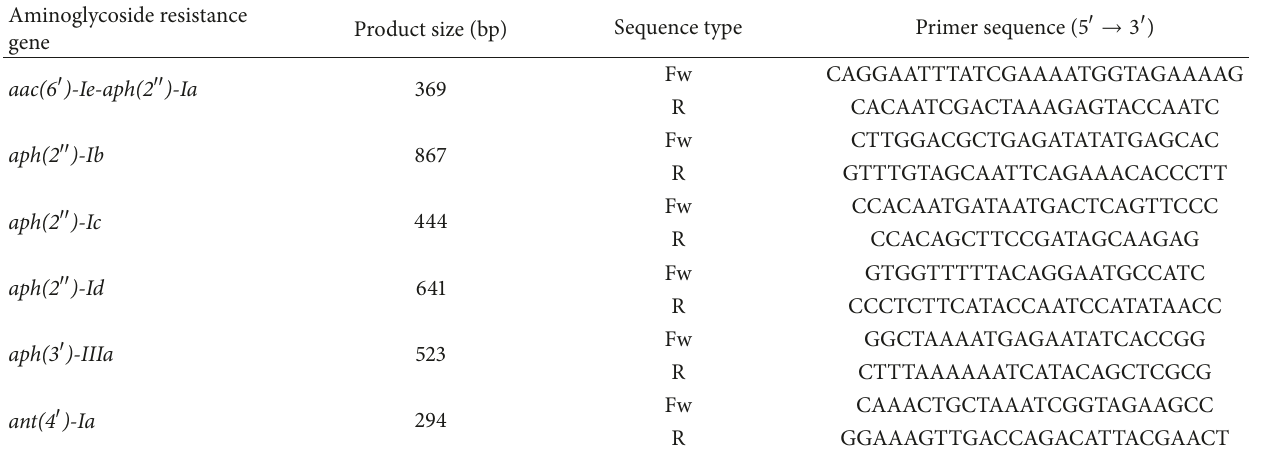
Table 1: Primers used in the multiplex PCR